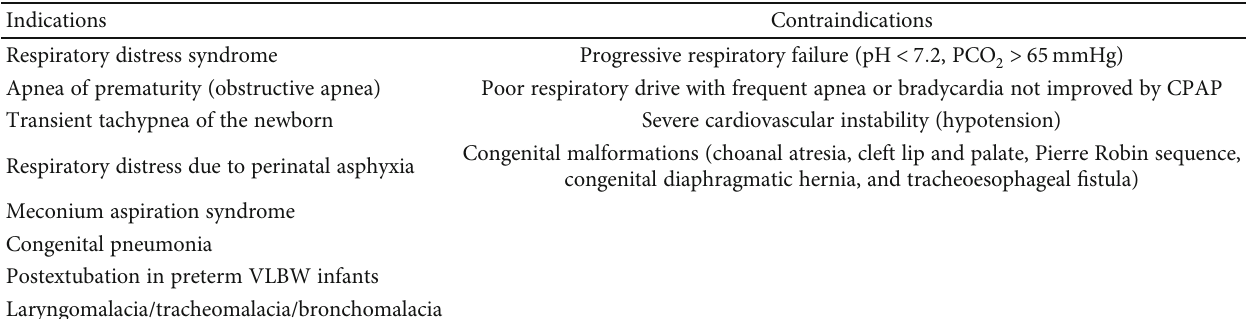
Table 1: Indications and contraindications for NCPAP.